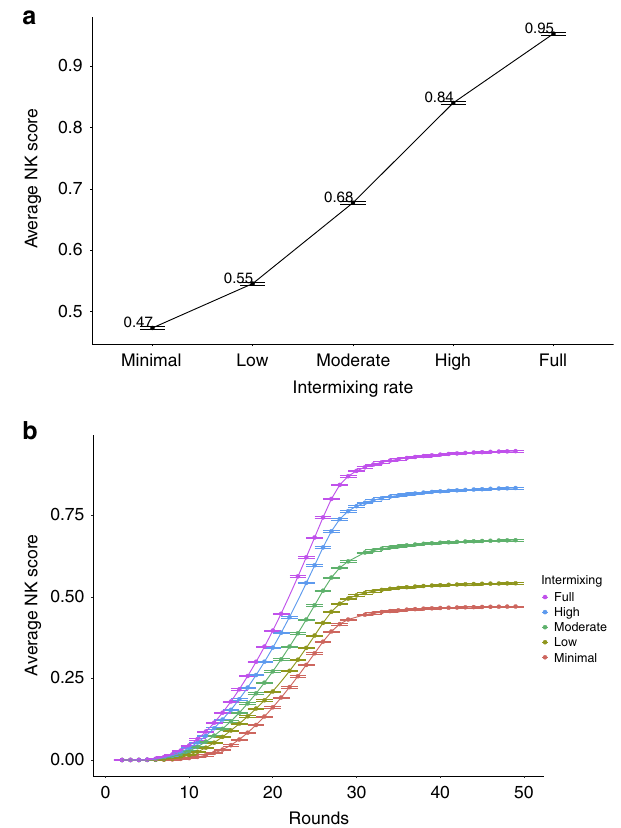
Fig. 4 Diverse ability intermixing performance. a The average NK score of networks across problem spaces, plotted by intermixing rates for the diversity of ability simulations. b The average NK score of networks across problem spaces, plotted over time for the diversity of ability simulations by intermixing rates. Error bars are the standard errors measured across NK